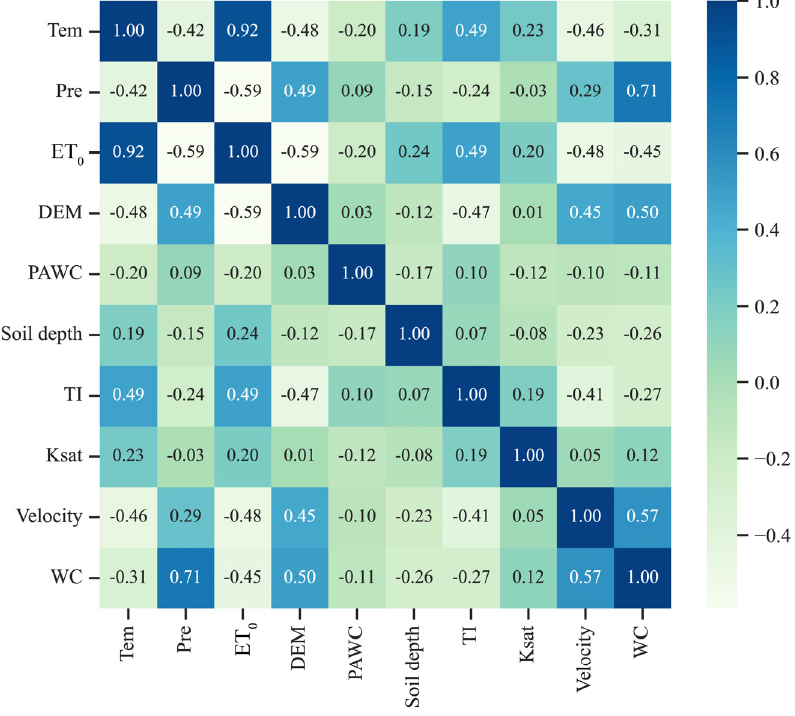
Figure 7. Correlation analysis of the driving factors of water conservation. Tem is temperature; Pre is precipitation; ET 0 is potential evapotranspiration; DEM is digital elevation; PAWC is plant available water content.